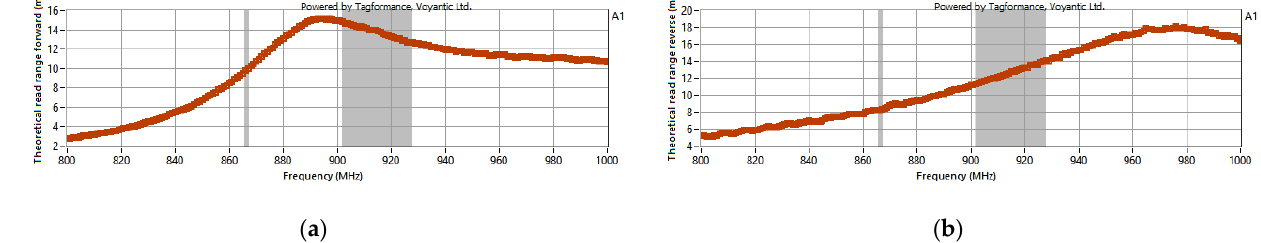
transponder (Figure 22).